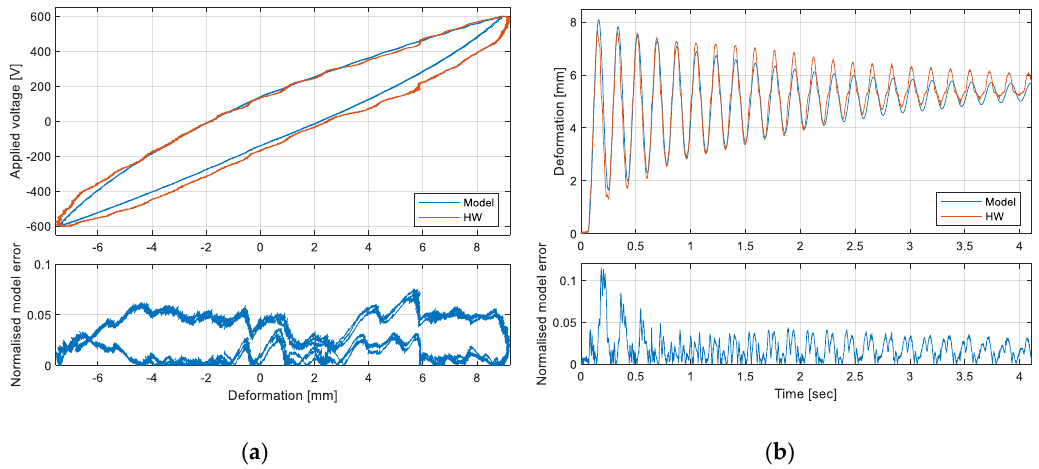
Figure 7. Validation of the model via time-domain responses: ( a ) hysteresis deformation loop with sinewave voltage input at 0.01 Hz; ( b ) deformation response to step voltage input of 300 V.